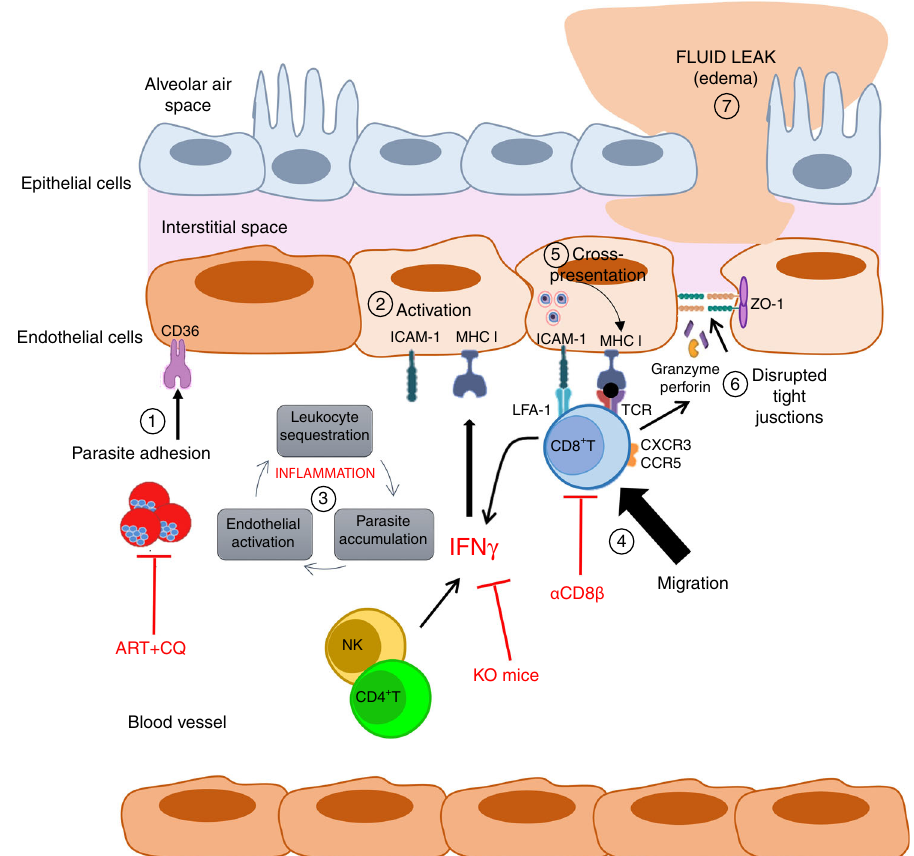
Fig. 10 Proposed mechanism for malaria-associated lung injury pathogenesis and approaches to modulate pathology. Following PbA luc infection in C57BL/ 6 mice, (1) circulating iRBC (mature stages of the parasite) bind to CD36 receptor expressed on lung endothelial cells, initiating and amplifying the